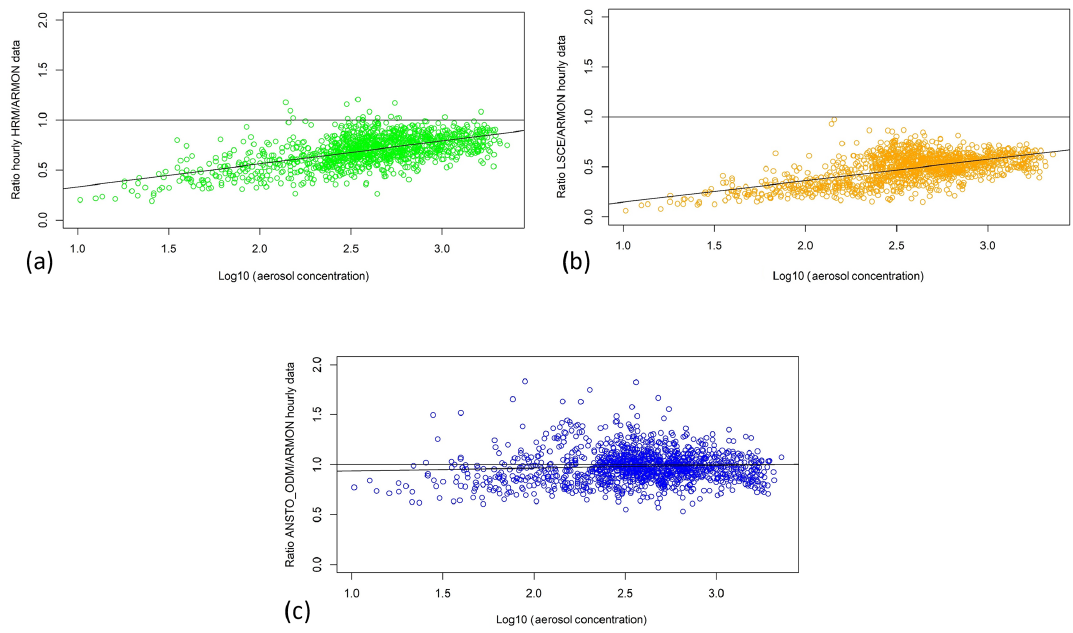
Figure 6. Ratio of the atmospheric 222 Rn or 214 Po activity concentration measured by the HRM (green dots), LSCE (orange dots), and ANSTO_ODM (blue dots) monitors and those measured by the reference ARMON monitor against the logarithm of the atmospheric aerosol concentration measured at the ODM